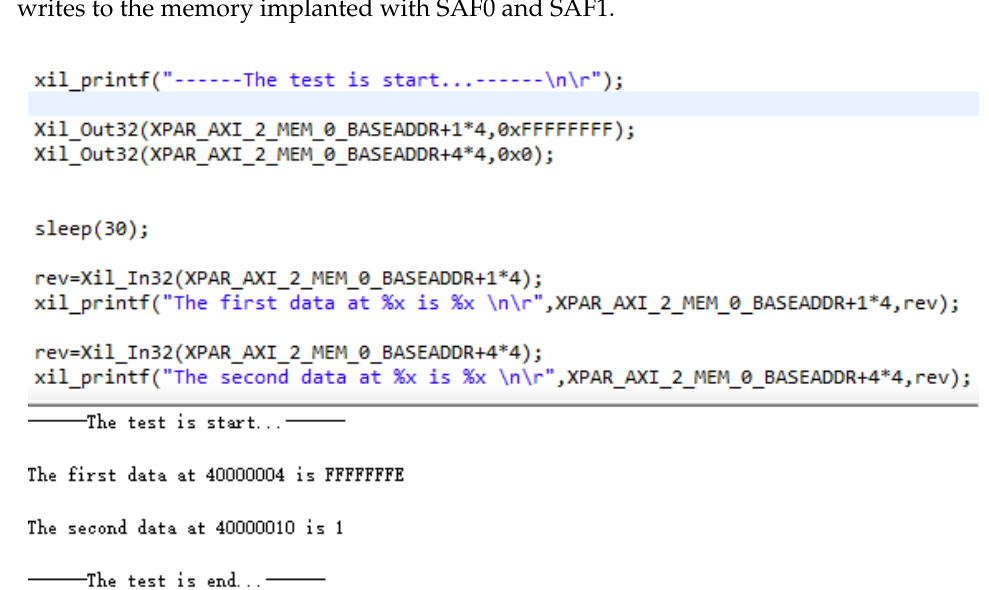
Figure 12. Read result of RDAMS implanted with stuck at fault (SAF)0 and SAF1.